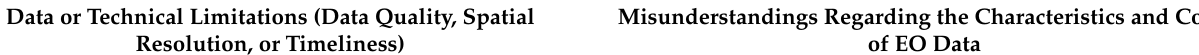
Table 2. Potential opportunities to minimize EO applicability challenges for DRR in